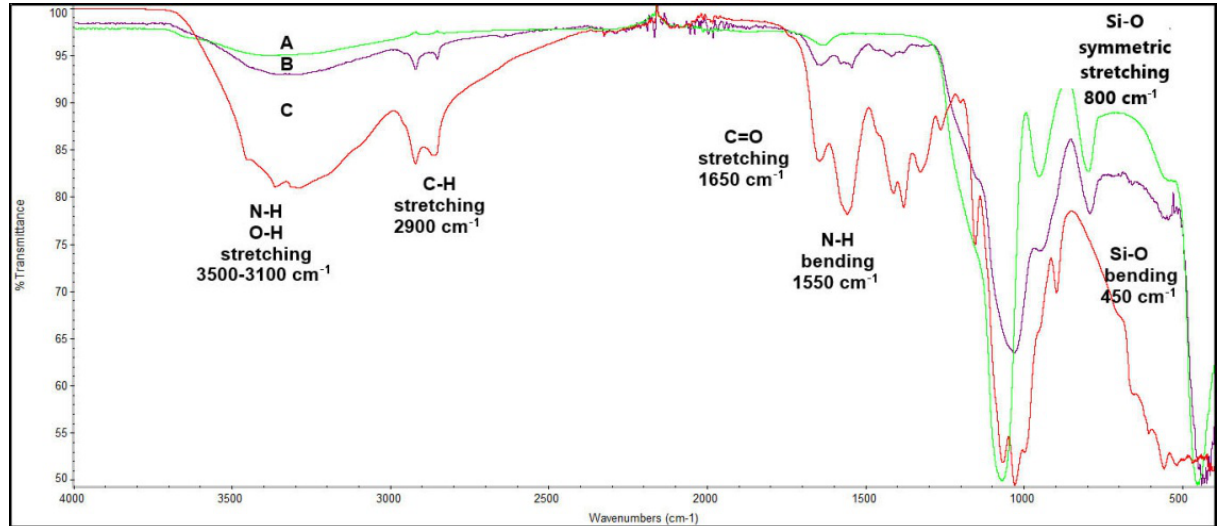
Figure 2. FT-IR IR Spectra. (A) Sol-Si particles, (B) CS/Sol-Si biocomposite, (C) CS.